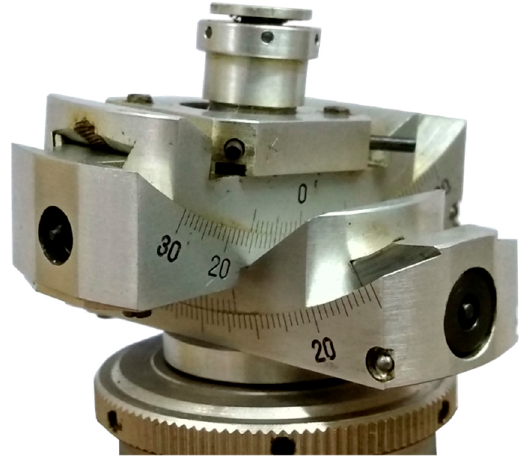
Figure 10. A special goniometer head was designed and manufactured for in situ X-ray studies.